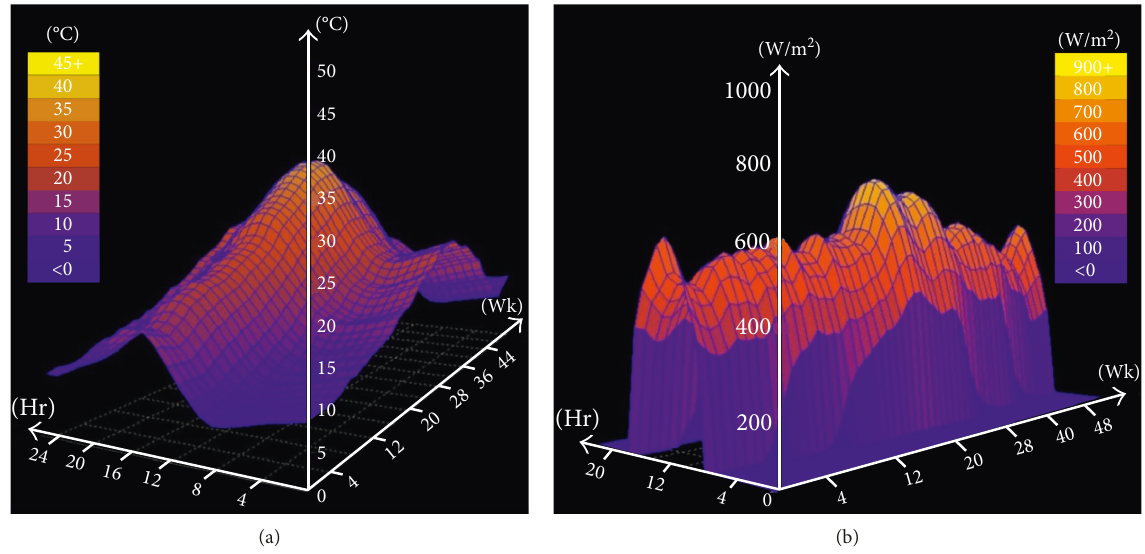
Figure 6: Graphs of average temperature and solar radiation, location Seville, Spain. (a) Weekly summary average temperature ( ° C). (b) Weekly summary direct solar radiation (W/m 2